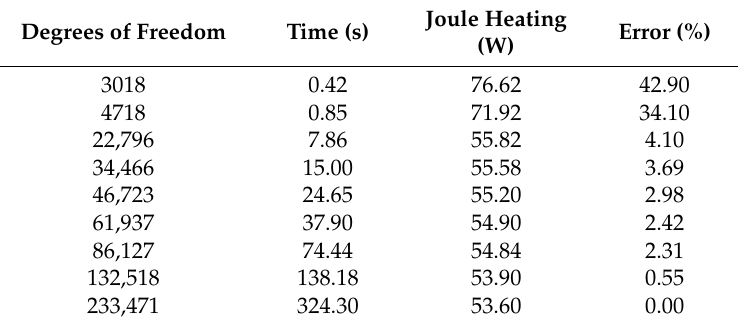
Table 3. Evolution of the error and the execution